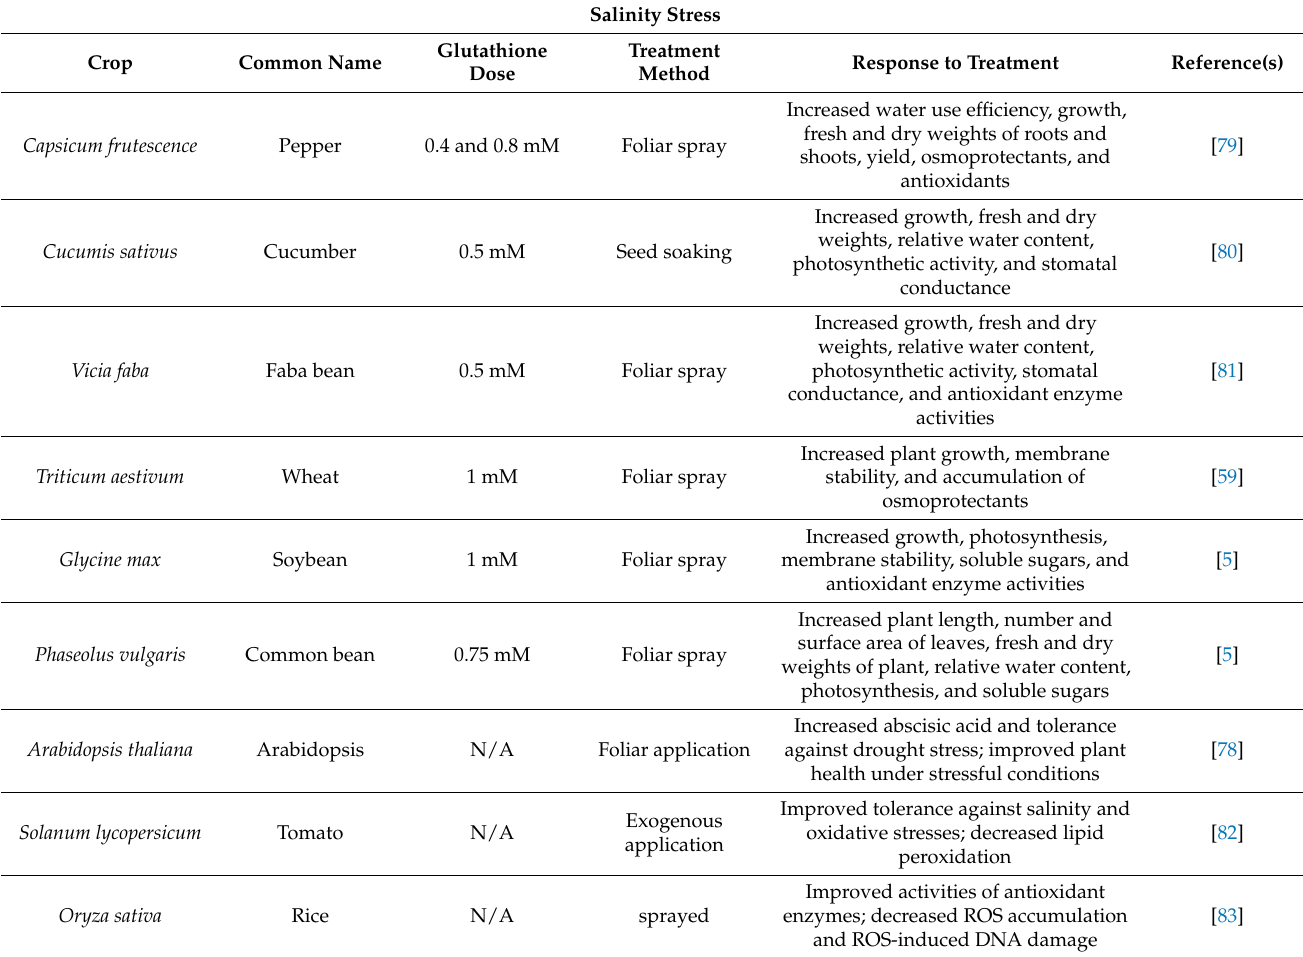
Table 7. Physiological responses of various crops to glutathione treatment against salinity